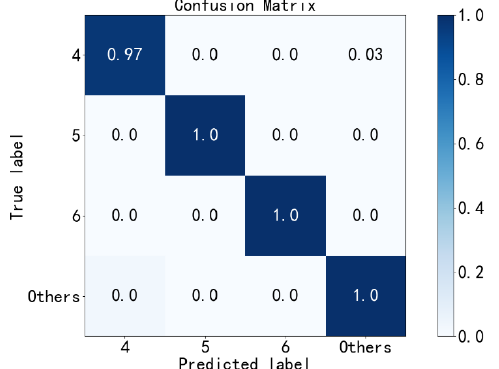
Figure 12. Third fault diagnosis with the PE method.